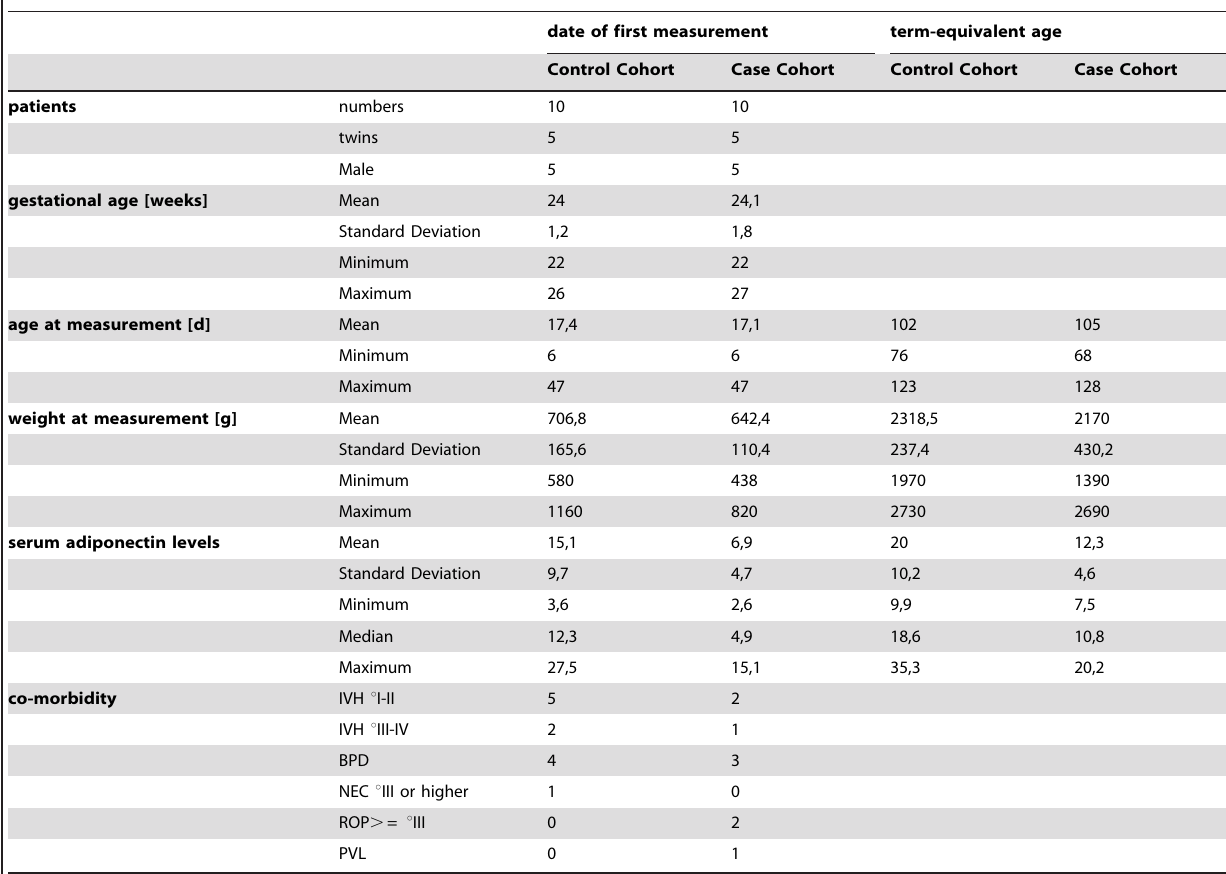
Table 1. Patients’ demographic